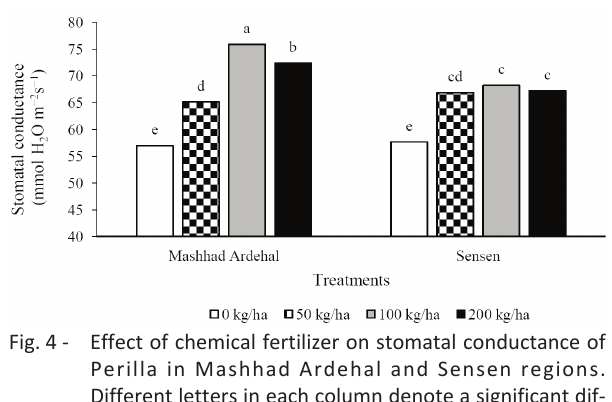
Fig. 4 - Effect of chemical fertilizer on stomatal conductance of Perilla in Mashhad Ardehal and Sensen regions. Different letters in each column denote a significant dif- ference at p≤0.05 (LSD